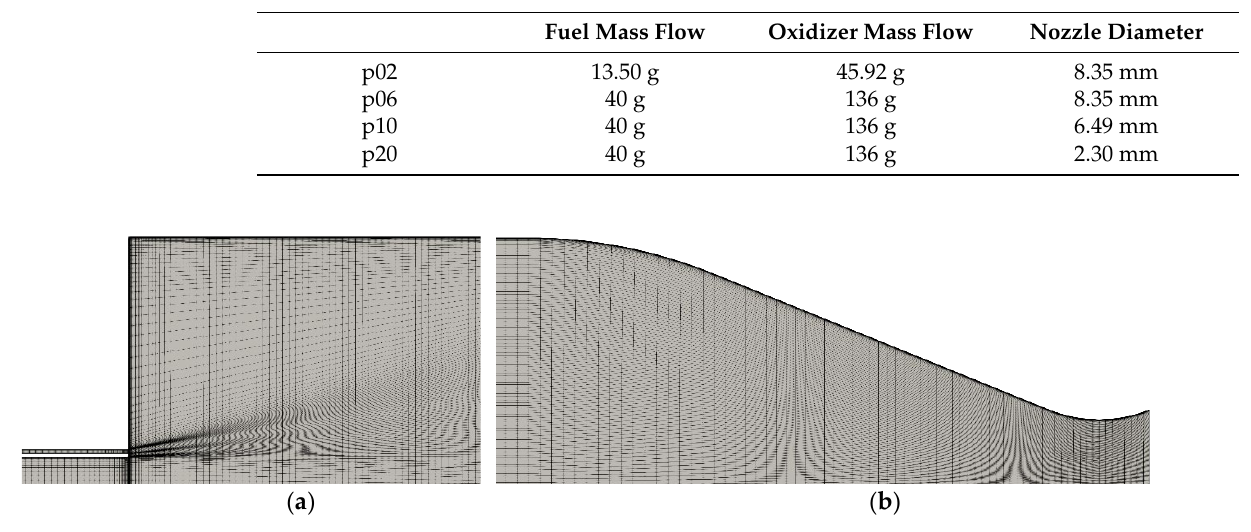
Figure 6. Numerical mesh for the CFD simulation: ( a ) inlet and ( b ) nozzle.